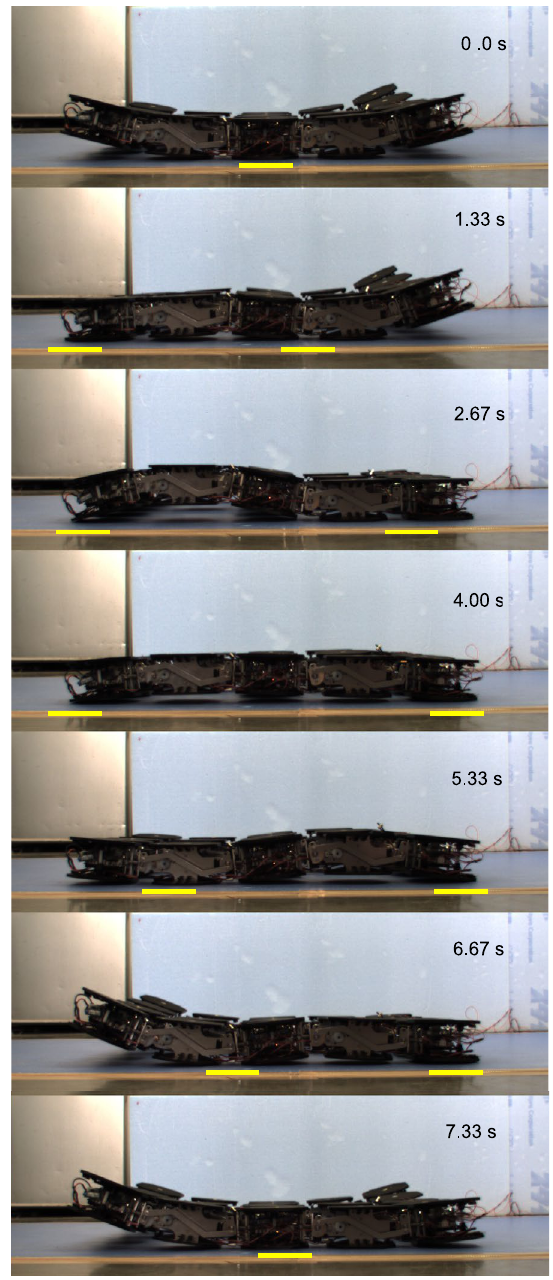
Fig. 16 Translational locomotion of WORMESH-II for IMF (wave parameters are A = 0.13 π , ω = π/ 20 , and β = 3 π/ 2